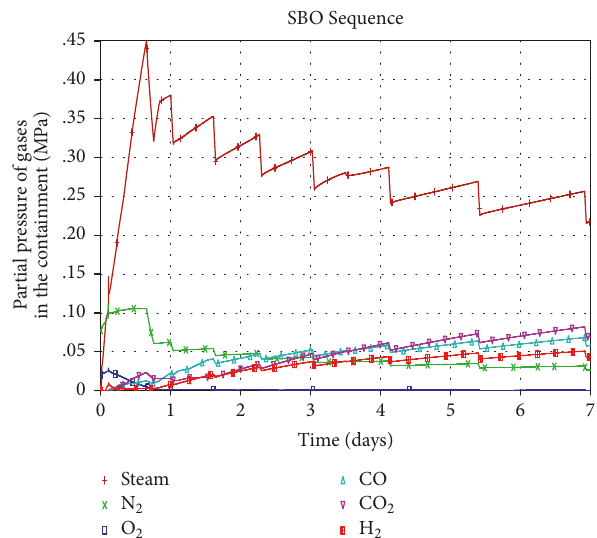
Figure 8: Gas partial pressures in the containment (ASTEC calcu- lation).